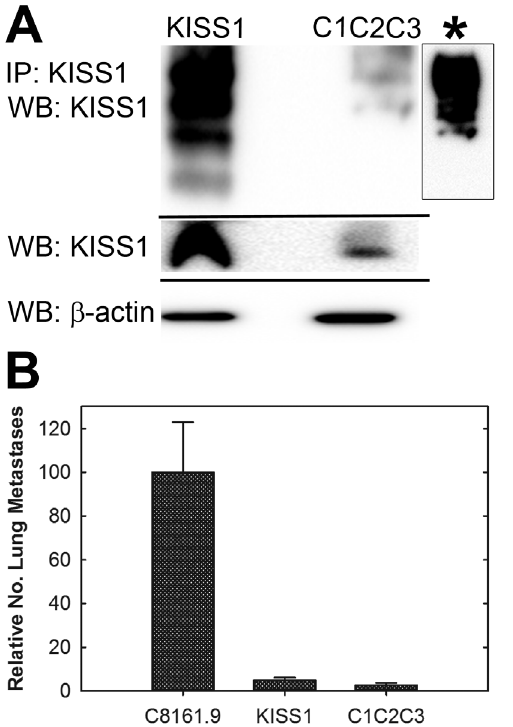
Figure 4. Mutation of putative PC sites in KISS1 blocks KP generation but does not abrogate metastasis suppressor function. A. Immunoblot showing KISS1 processing-deficient mutant (C1C2C3) which was mutated at the three putative furin processing sites (KISS1 K57A/R67A/R124A ). C1C2C3 was not processed into KP [Compare to Figure 1A and Figure 1B]. * indicates C1C2C3 lane which was over- exposed to highlight lack of laddering below the full-length KISS1 band. B. Relative lung metastases (mean 6 SEM) compared to C8161.9 (647 6 149 metastases). KISS1 and C1C2C3 transfected cells were significantly less